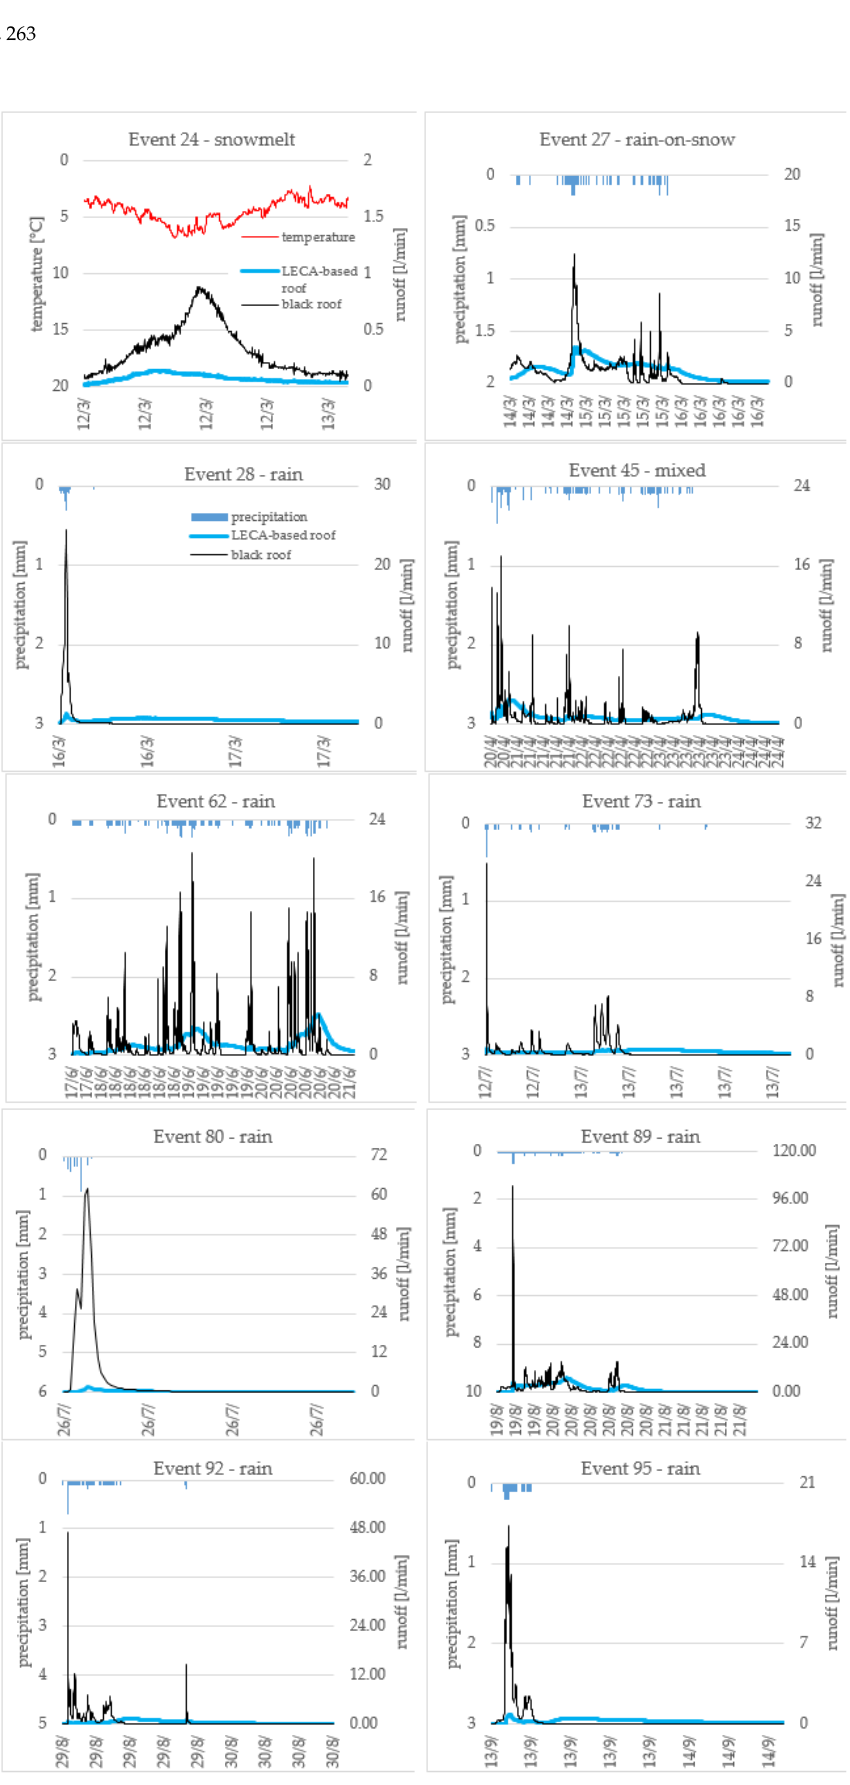
Figure 4. The events with the highest peak 5-min intensity.